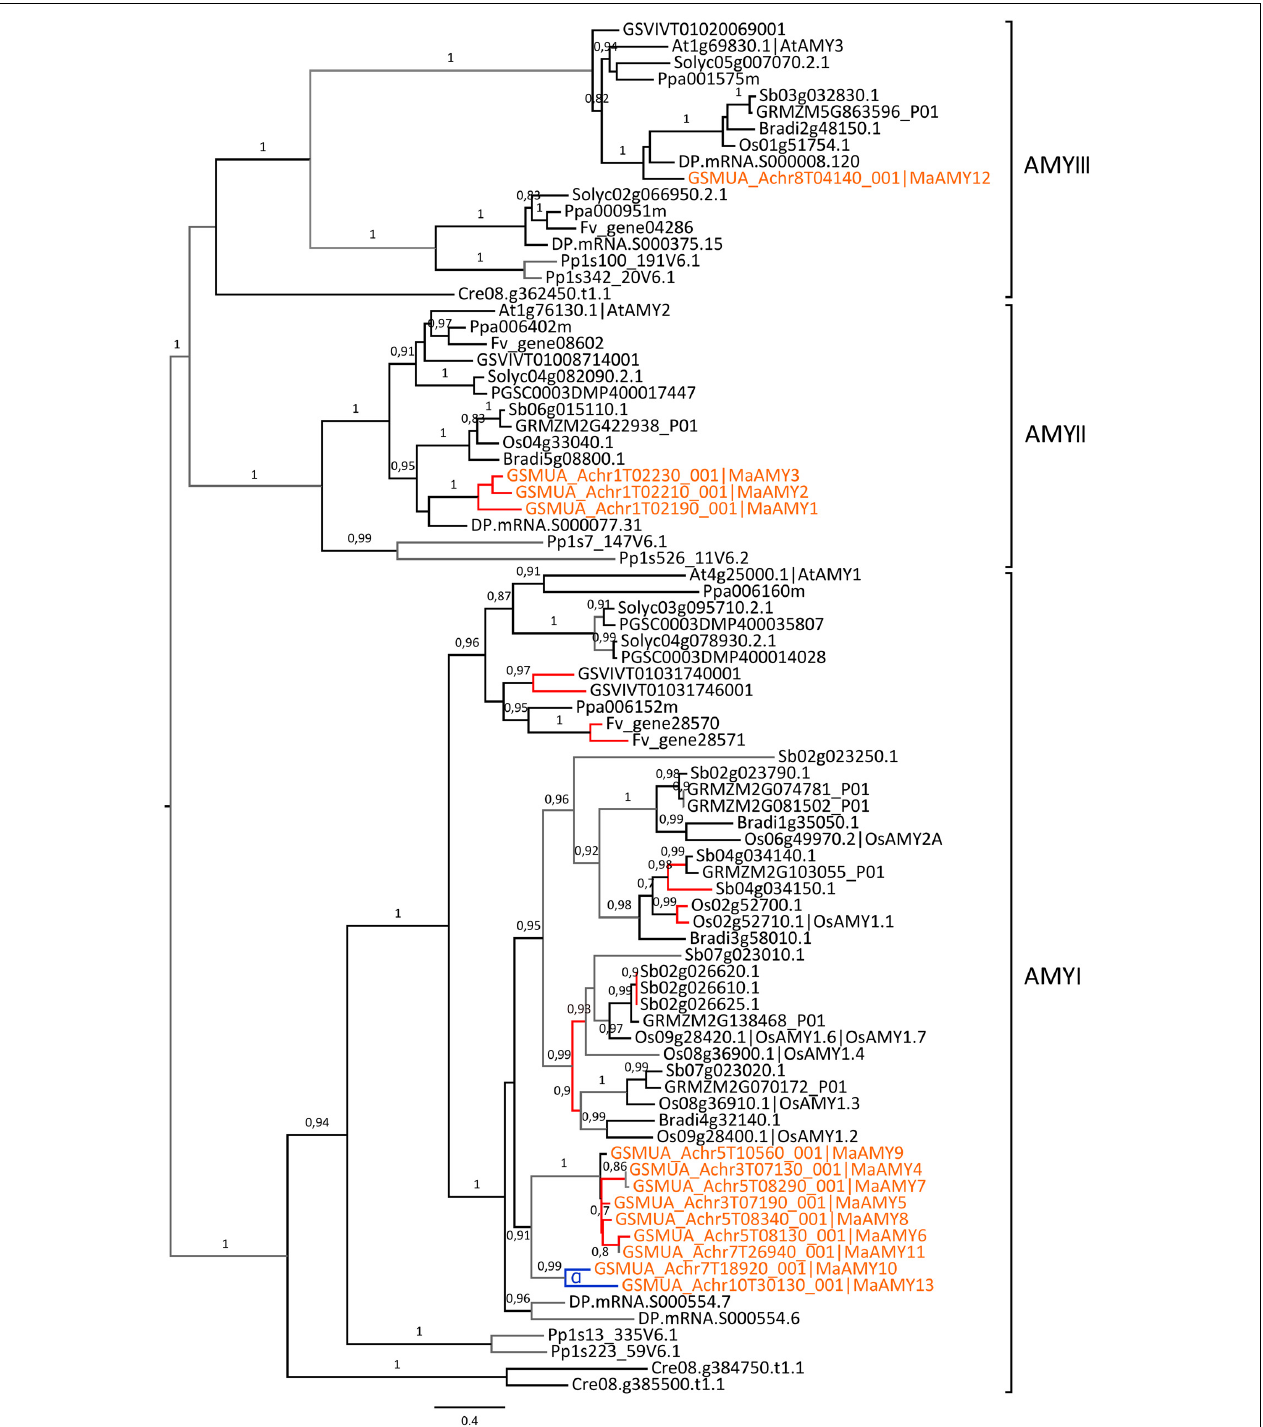
FIGURE 6 | Acquisition of AMY genes through tandem/proximal duplications. The maximum likelihood tree of AMY predicted proteins was rooted on midpoint. Branch supports > 0.70 (aLRT statistics with SH–like procedure) are indicated. Chlamydomonas reinhardtii (Cre), Physcomitrella patens (Pp), grapevine (GSVIV), tomato (Solyc), potato (PGSC), woodland strawberry (Fv), Arabidopsis (At), peach (Ppa), Brachypodium (Bradi), rice (Os), maize (GRMZM), sorghum (Sb), date palm (DP) and banana (GSMUA) identifiers are indicated (in brown for banana). Branches are colored according to gene duplication modes: WGD (blue), tandem/proximal (red) and unknown (gray). Black branches correspond to speciation events. WGD events identified using reconstructed ancestral blocks are indicated (blue letters). The scale bar corresponds to estimated amino acid substitutions per site. Sequences were grouped using the tree topology and nomenclature of Arabidopsis AMY